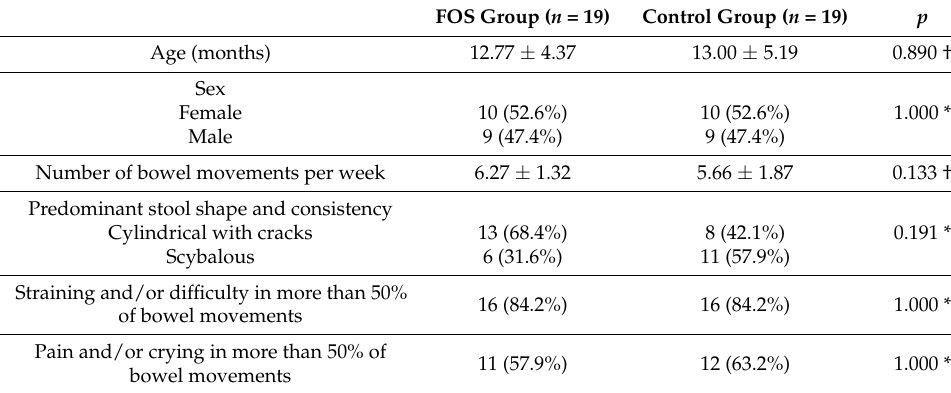
Table 1. Demographic and clinical characteristics at